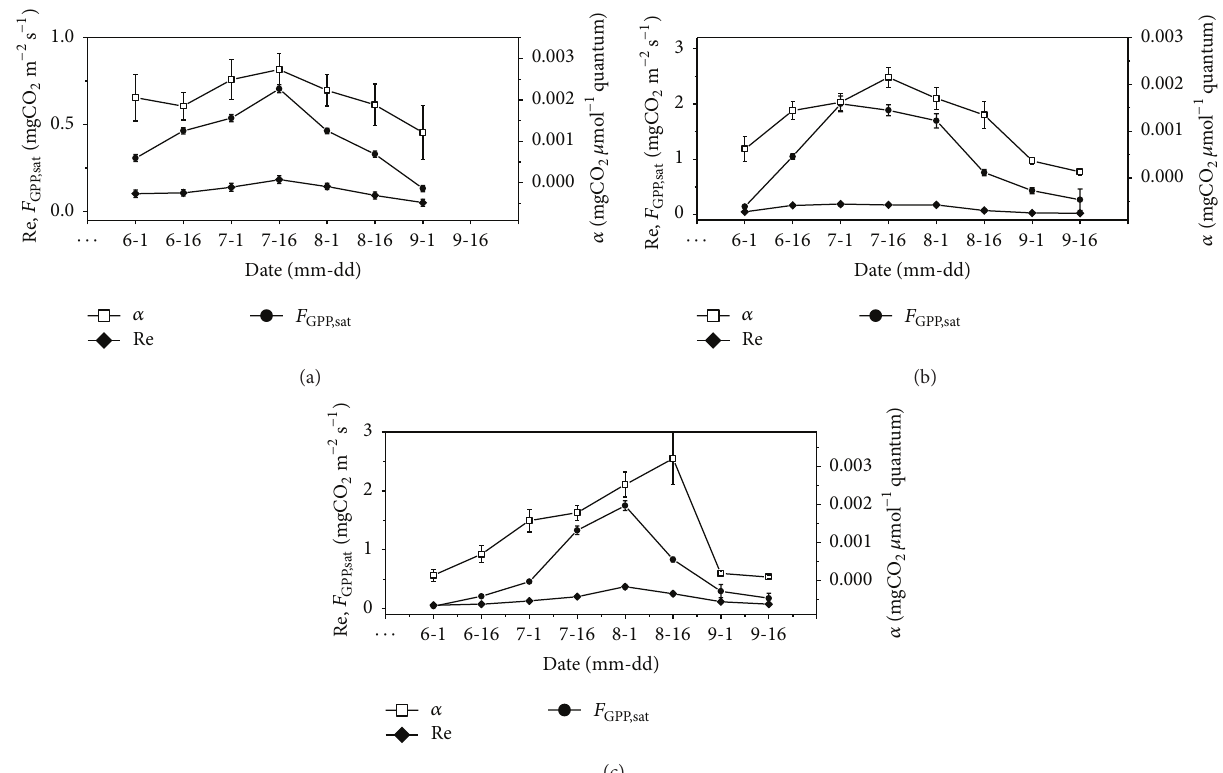
Figure 1: Seasonal variation of the parameters in Michaelis–Menten functions at (a) marsh, (b) rice, and (c) soybean sites. After introducing artificial gaps for each of the four datasets, the respective gap-filling methods were param- eterized with the remaining data and applied to fill the artificial datasets. The gap-filling error was calculated using the observed fluxes in these artificial gaps to validate the predictions of each filling